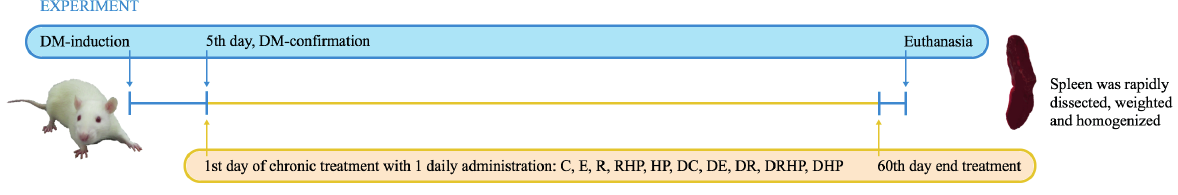
Figure 1 - Schematic view of the experimental protocol. experimental induction of diabetics was provoked by a single intraperitoneal injection of 60 mg streptozotocin (STZ)/kg body mass of rat. Treatment refers to the C (Control), e (ethanol), R (Resveratrol), RHP (Resveratrol-hydroxypropyl-β-cyclodextrin), HP (Hydroxypropyl-β-cyclodextrin), DC (Diabetic control), DE (Diabetic ethanol), DR (Diabetic resveratrol), DRHP (Diabetic resveratrol-hydroxypropyl-β-cyclodextrin) and DHP (Diabetic Hydroxypropyl-β-